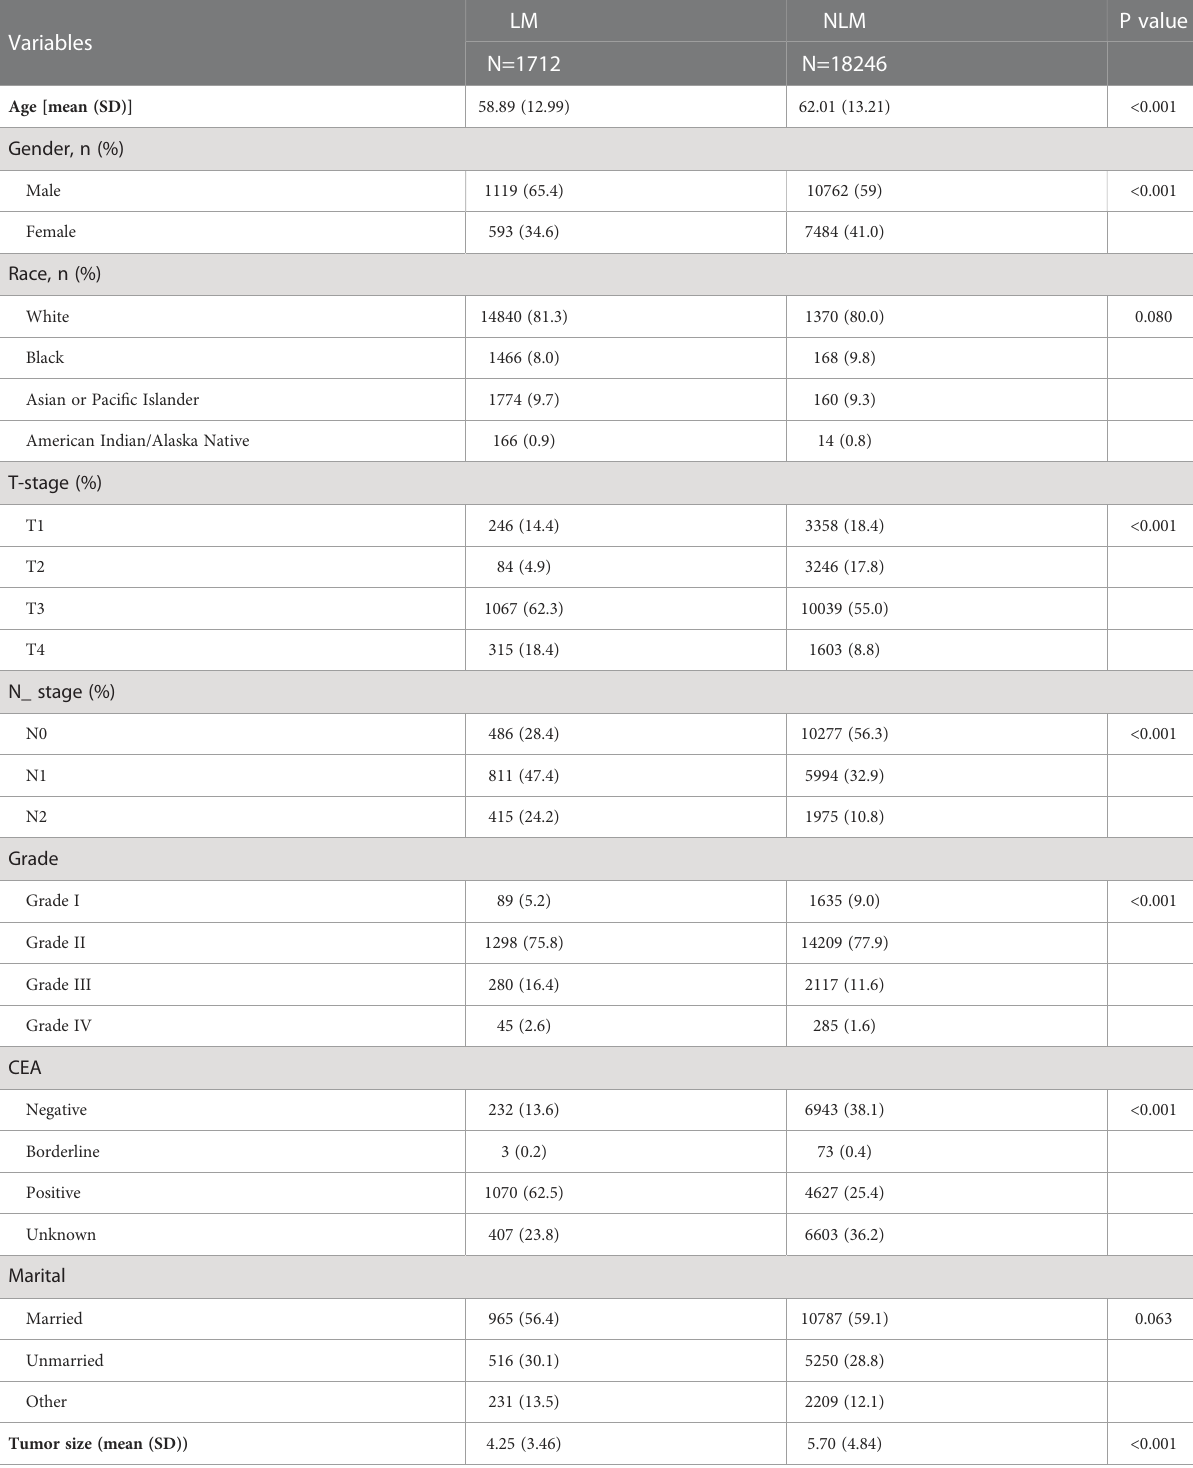
Distributions of clinicopathological characteristics in two